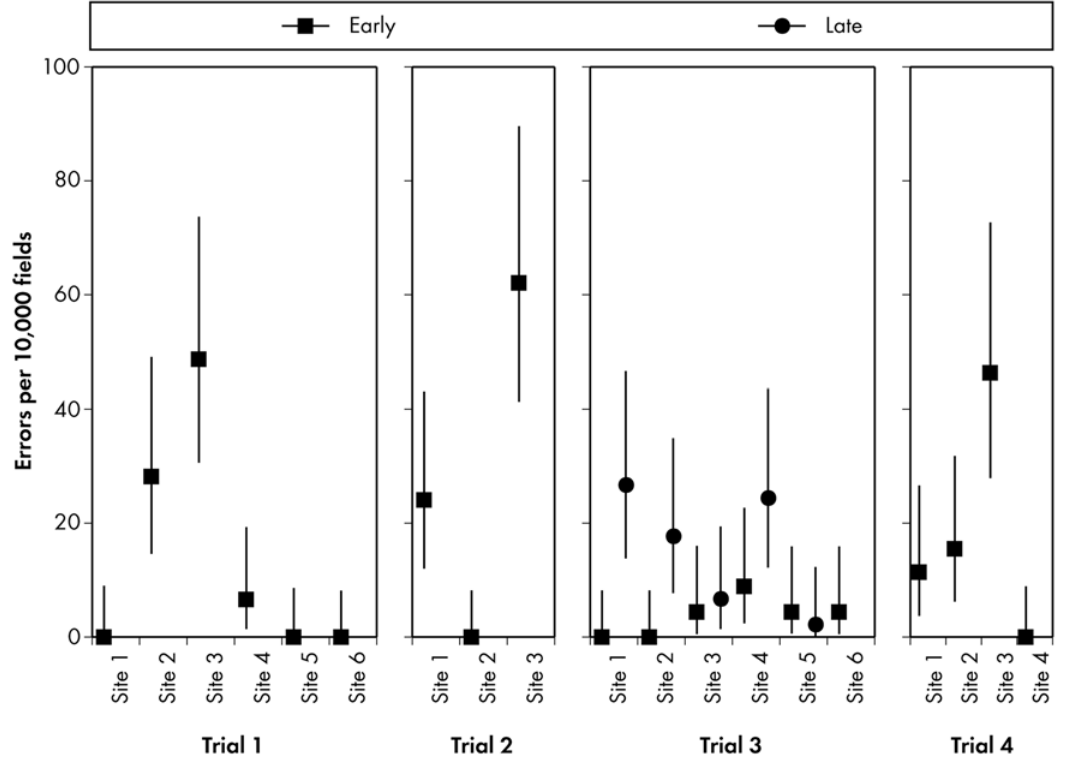
Figure 3. Source-to-Database Audit Error Rates for CTN EDC Trials 1–4. The first source-to-database audit (‘‘early’’) was performed when 20%–30% of expected subject enrollment was reached; the second database audit (‘‘late’’) was performed when 70%–80% of expected enrollment was reached.